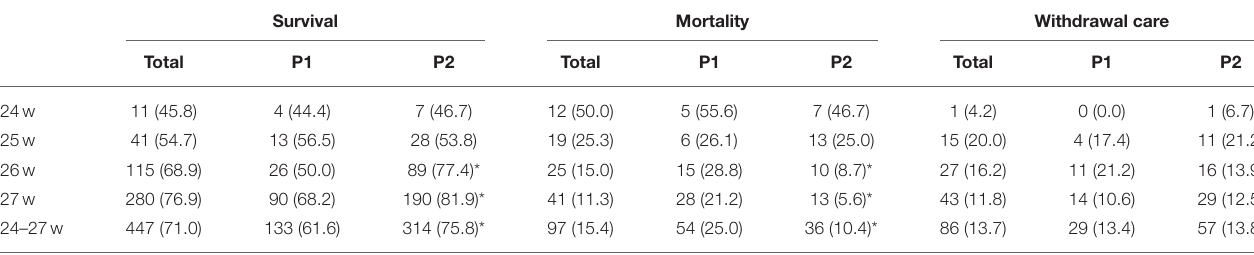
TABLE 2 | Rates of survival, mortality, and withdrawal care in P1 (2010–2014) and P2 (2015–2019) by gestational weeks, n (%).